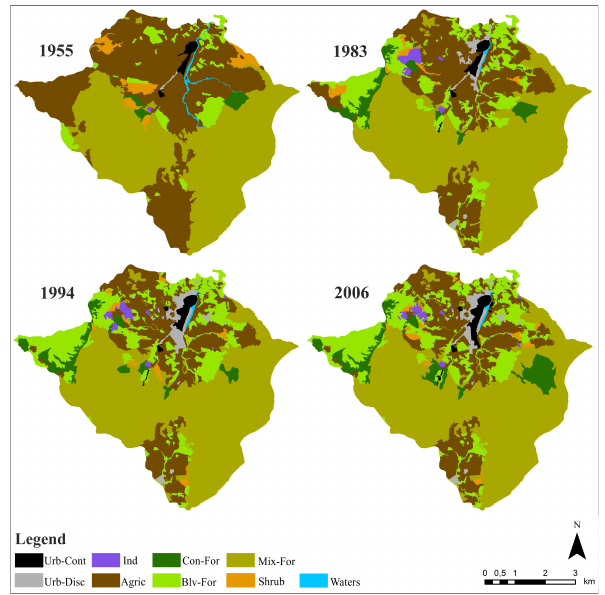
Fig. 3. LULC maps of the study area for all years under investiga- tion and graphical representation according to the LULC class types